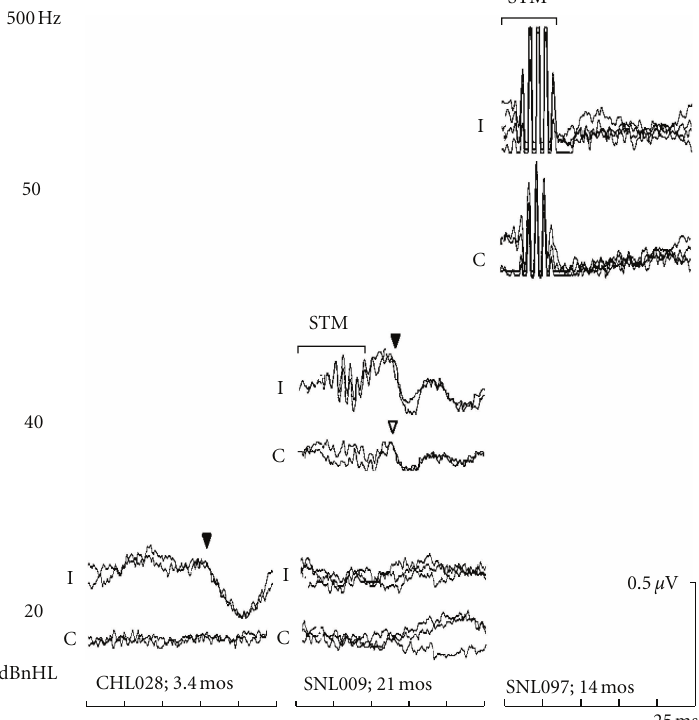
Figure 4: Left panel: ABRs to 20dBnHL BC 500 Hz tones recorded from an infant with conductive hearing loss at the time of ABR testing, who showed normal hearing at behavioural followup. Middle panel: “Elevated” 500 Hz BC-ABR results (threshold = 30–40 dBnHL) from an infant who showed a moderate sensorineural hearing loss behaviourally. Right panel: “Elevated” 500Hz BC-ABR results (threshold > 50dBnHL) from an infant with a severe/profound sensorineural hearing loss bilaterally at followup. STM indicates the region of uncancelled stimulus artifact.